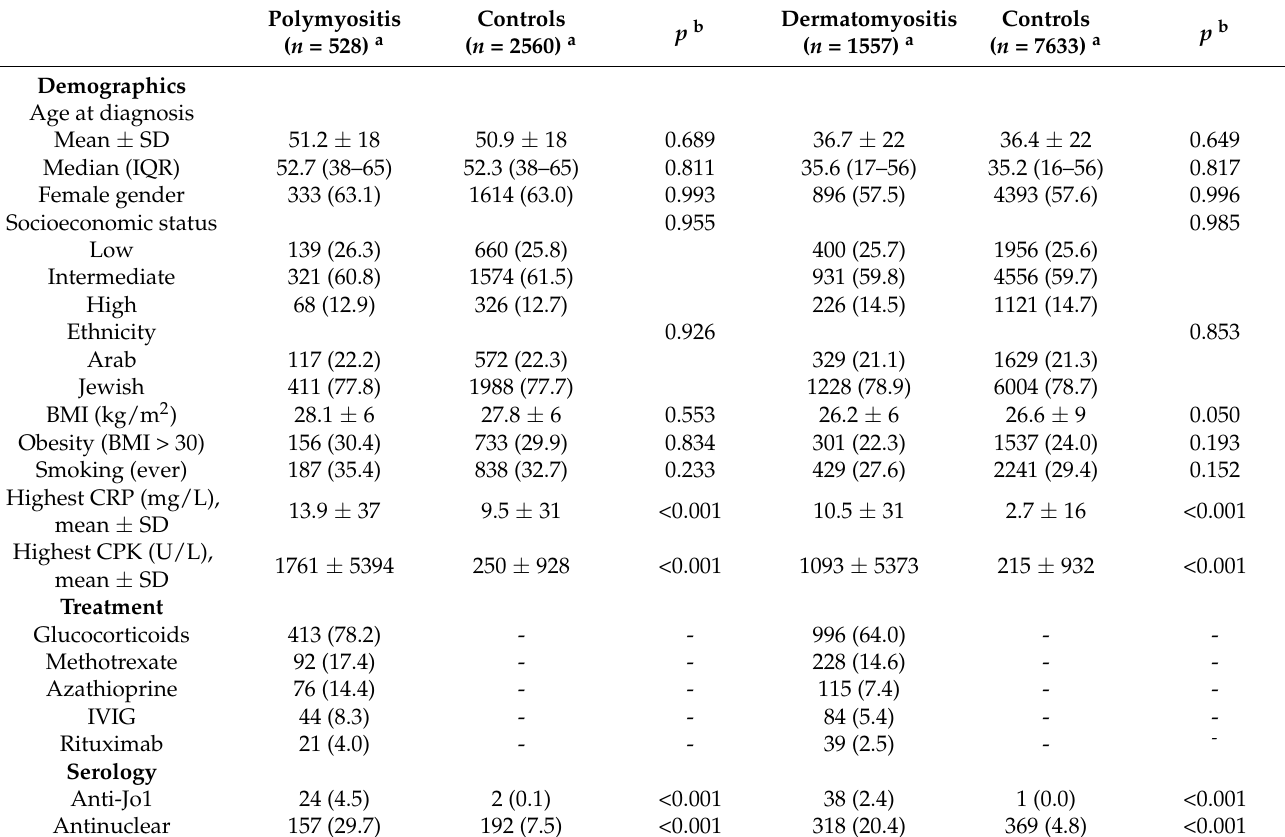
Table 1. Baseline chrematistics of the study population.